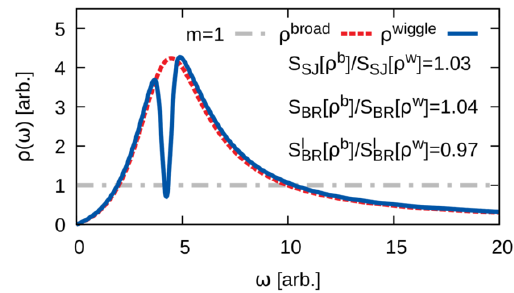
Figure 1 . Illustration of the possibility for local regulators, such as S BR and the Shannon-Jaynes Entropy S SJ to favor a wiggly function instead of a smooth one, where both curves cover the same area. Since the values for S are by construction negative, a ratio > 1 corresponds to a higher probability for the wiggly function. Only the non-local BR regulator S ‘ higher penalty to the wiggly function